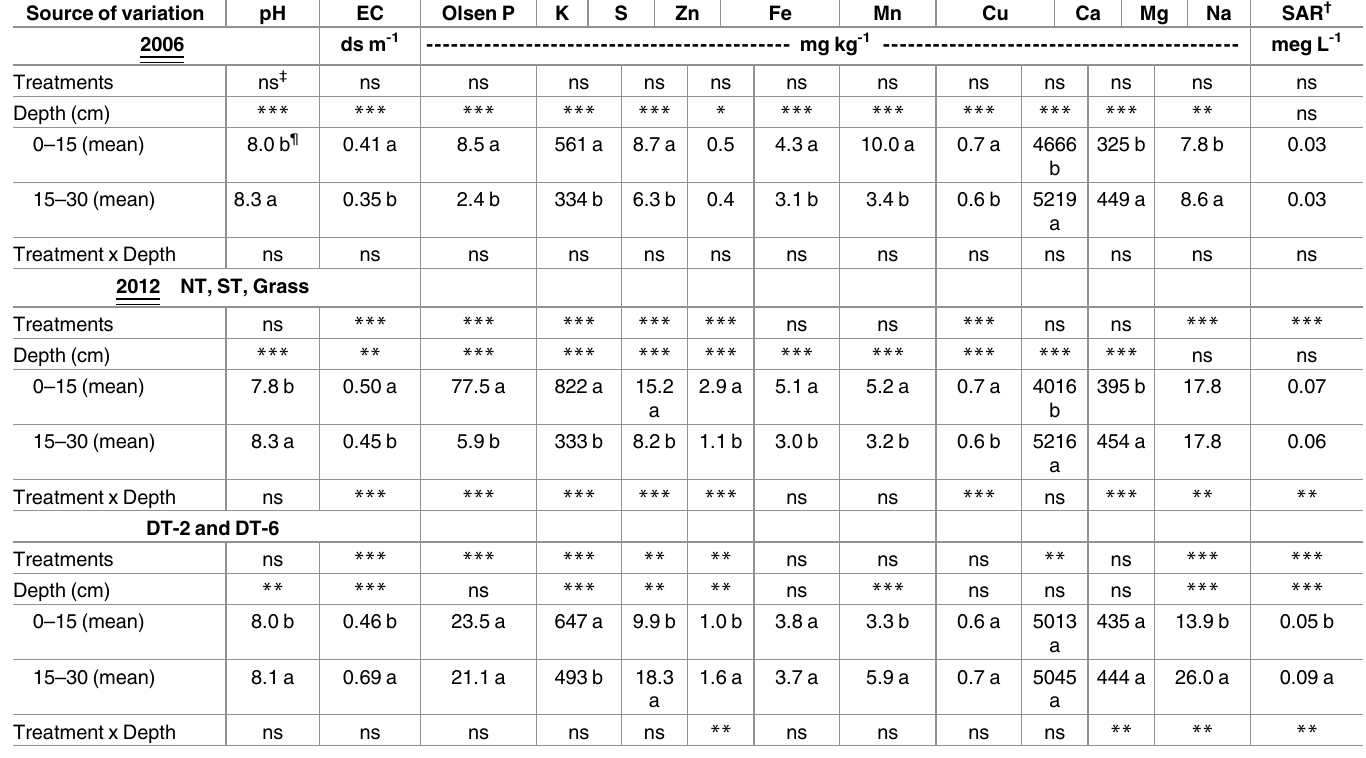
Table 8. Statistical significance of the effectsof different treatments averageacross depths, sampling depth (cm) averagedacross treatments, and the interaction of treatments x depth on soil chemical properties in 2006 and 2012 sampling dates. Source of